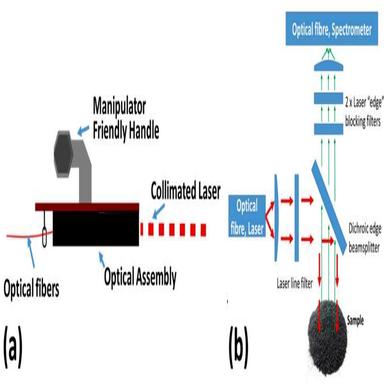
Schematic of (a) Stand-off Raman probe, (b) Stand-off Raman basic optical design (red lines represents laser, green line represents wavelength-shifted Raman signal (For interpretation of the references to colour in this figure legend, the reader is referred to the web version of this article).